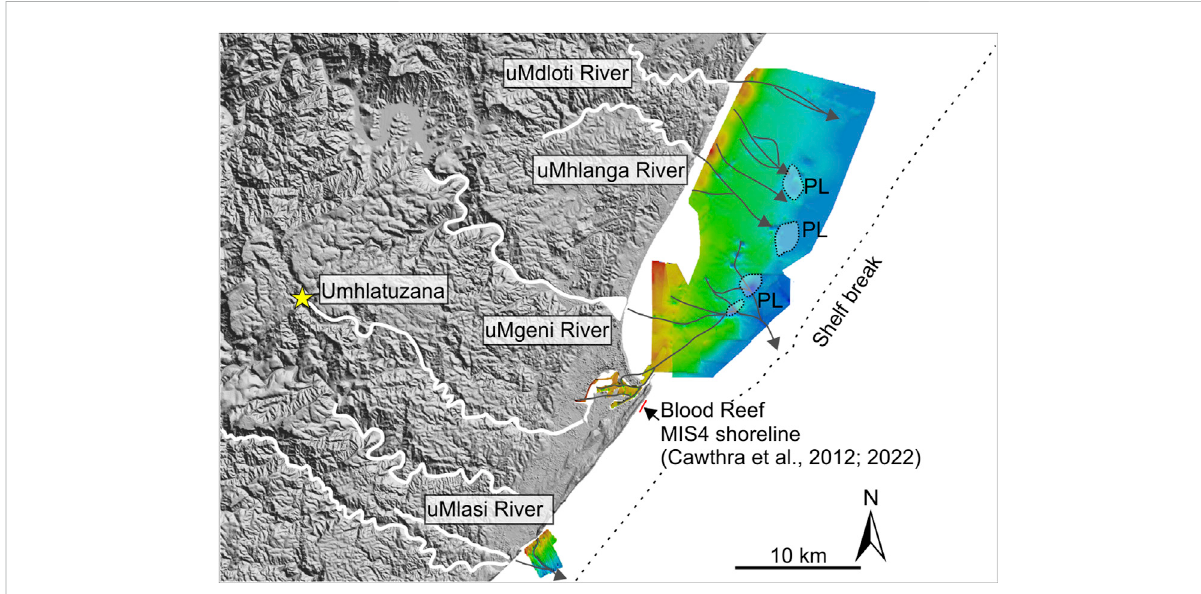
FIGURE 6 Bedrock surface offshore the greater Durban area based on available seismic data. The surface represents several periods of amalgamated subaerialexposure,re fl ectedinthedrainagepatterns.PL=paleo-lagoon.TheMIS4shorelineofCawthraetal.(2012,2022)ishighlighted.Suspected drainage.